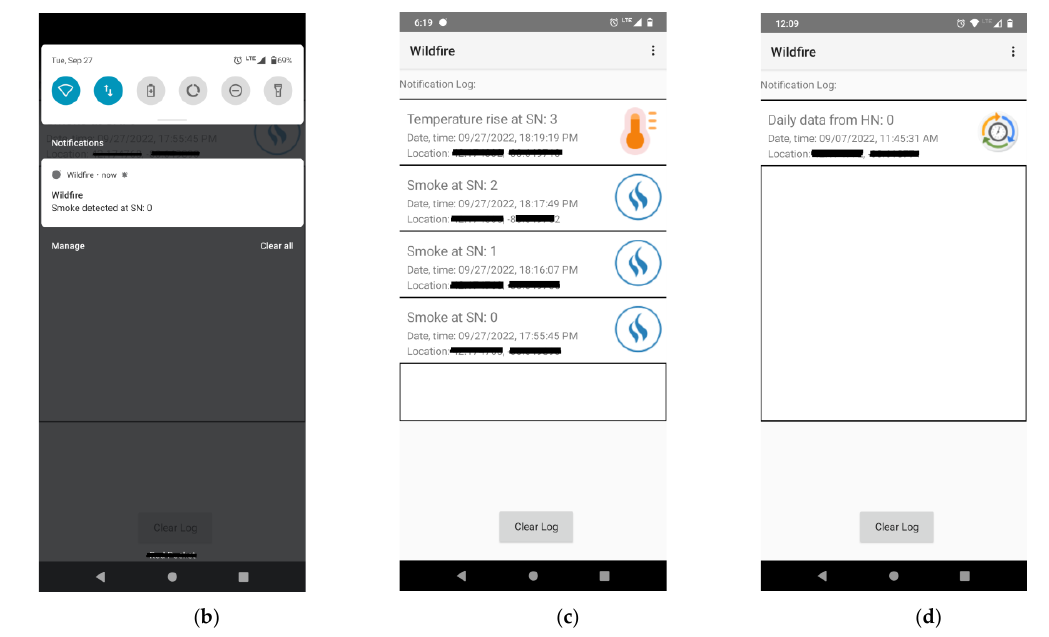
Figure 13. Screenshots of central server software and smartphone apps: ( a ) central server-marked fire event on map; ( b ) smartphone notification when smoke detected in sensor node 0; ( c ) smartphone app’s list view showing a list of fire events with location, date, and time; ( d ) smartphone notification confirming the reception of daily data at midnight.